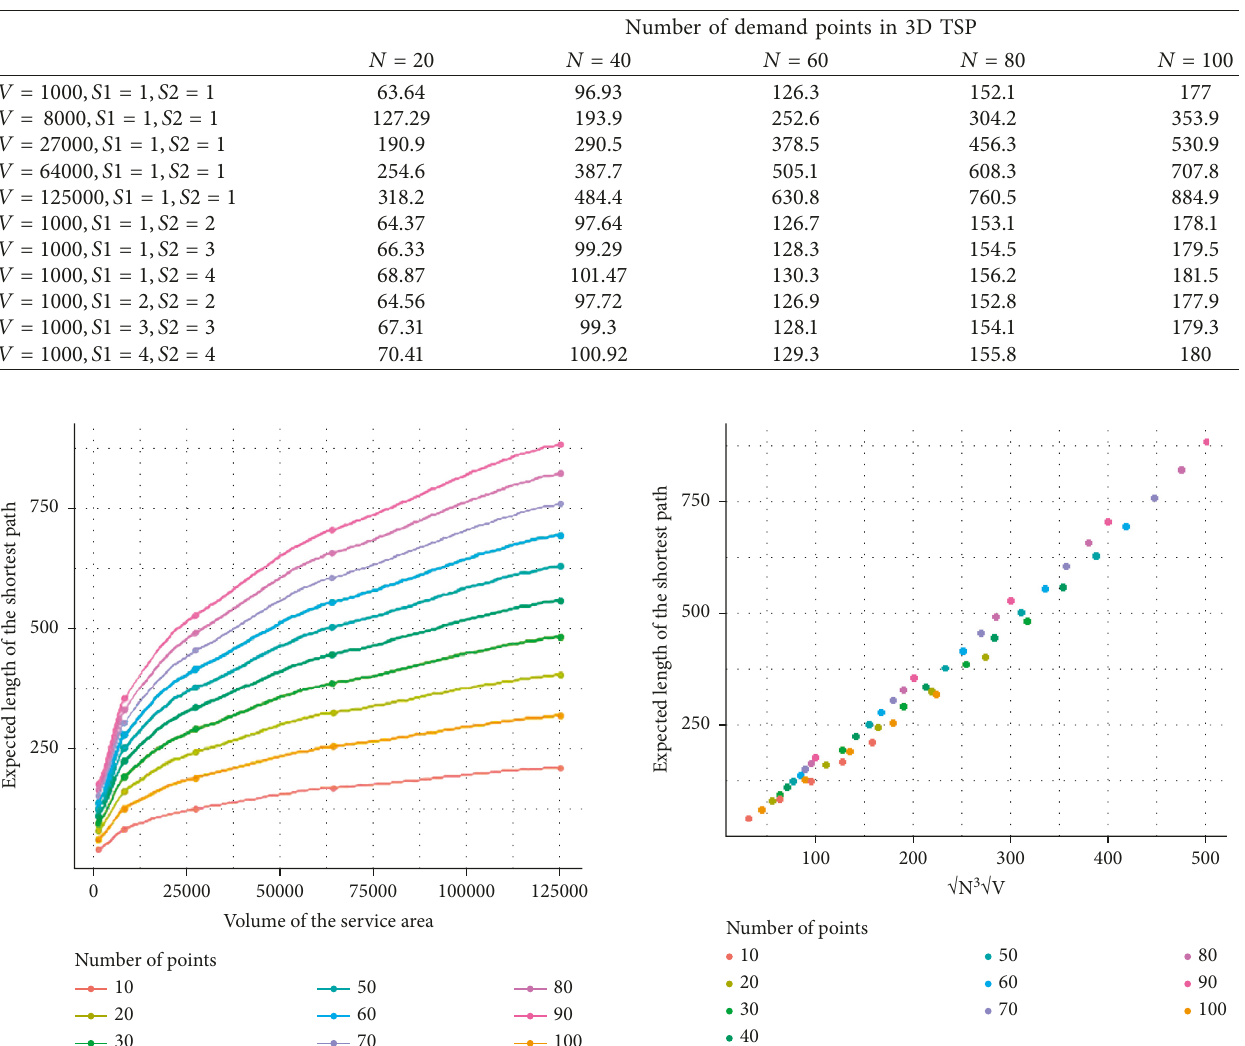
Table 4: Mean value of the shortest path length under different conditions.